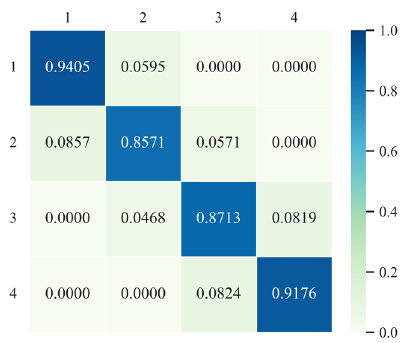
Figure 4. Markov transition probability matrix for CEI types at city level in the YRB from 2007 to 2017.